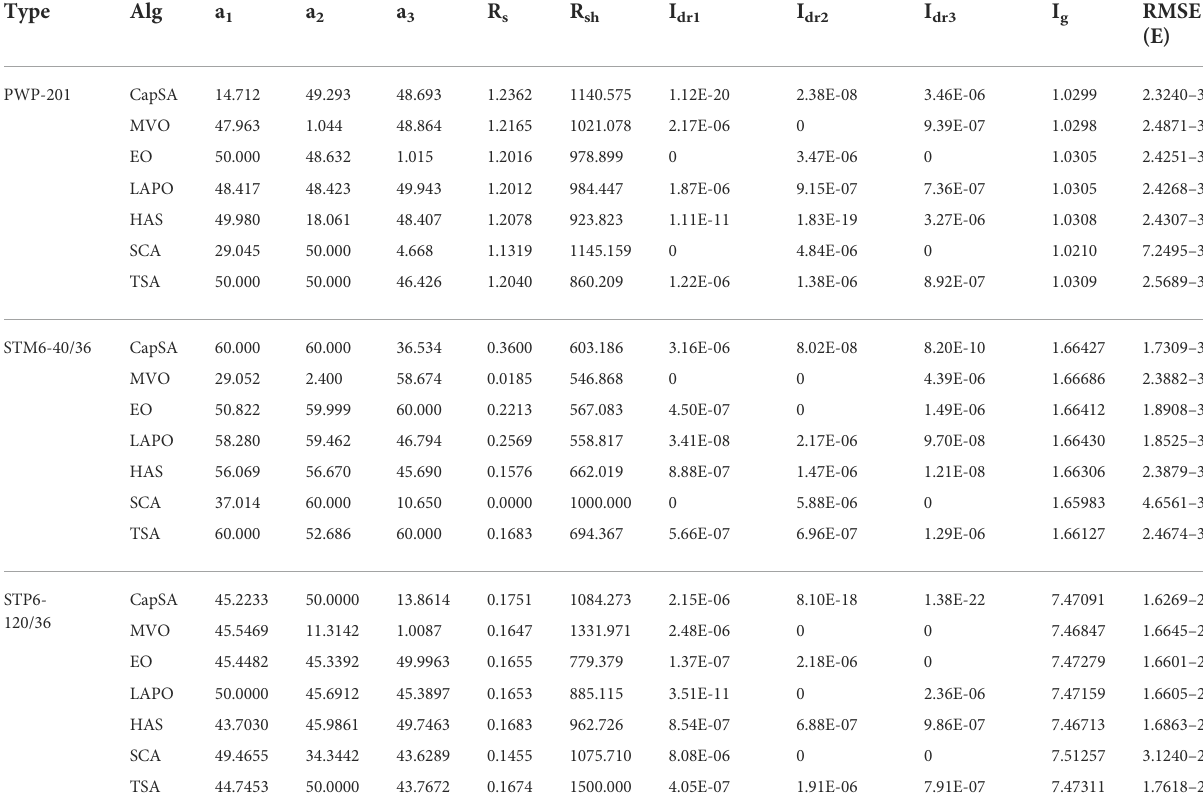
TABLE 8 TDM optimal parameters of PWP-201, STM6-40/36, and STP6-120/36